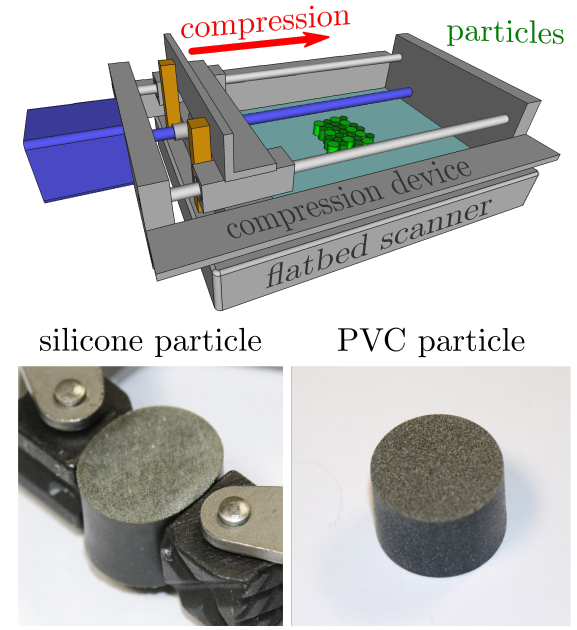
Figure 1. Experimental set-up. Top: 3D drawing of the com- pression device and particle packing laying on a photographic fl atbed scanner [15]. Bottom-left: squeezed soft silicone particle [13, 16]. The top shiny aspect is due to a layer of thin metallic glitter [17]. Bottom-right: rigid PVC particle. The top shiny as- pect is due to silver paint. During experiments particles are used with their shiny part in contact with the